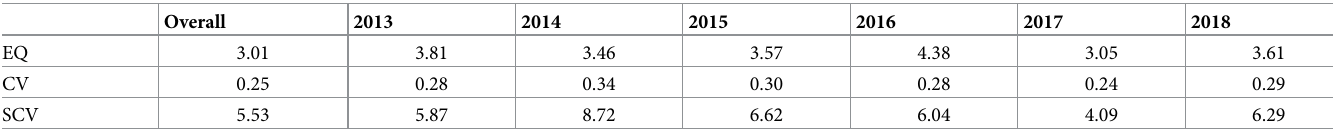
Table 2. Variation in prostate surgery rates across 44 Swiss Hospital Service Areas.